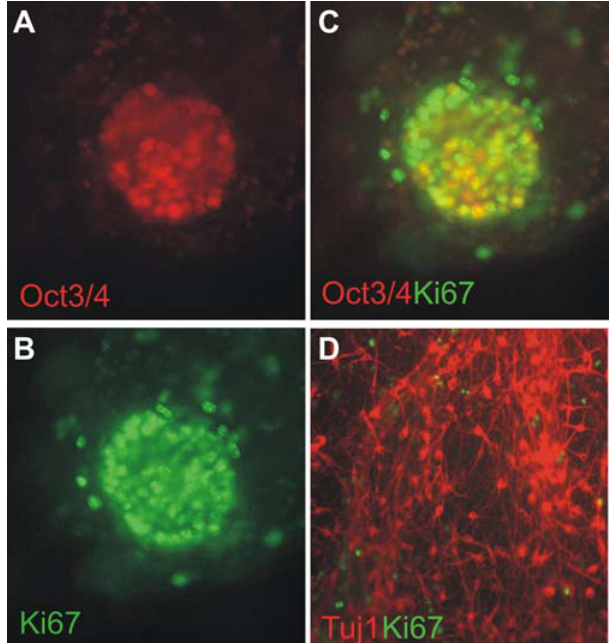
Figure 3. Some of the ES cell-derived neuronal colonies still contain at day 14 OCT3/4 and Ki67-positive cells. (A) After 14 days of differentiation culture few colonies (less than 5%), as exemplified here, still contain OCT3/4-positive cell clusters as detected by immunofluorescence staining using a specific mAb (magnification 40 6 ). (B) The same colony was stained by an anti-Ki67 mAb to detect proliferating cells. (C) The merged staining indicates that Ki67-positive proliferating cells exist which are not OCT3/4-positive stem cells. (D) In parallel, cells of the neuronal differentiation culture were stained at day 14 by anti-Ki67 and anti-Tuj1 mAb. The merged staining (magnification 20 6 ) indicates that the vast majority of the cells are Tuj1-positive neuronal cells. Few Ki67-positive proliferating cells are negative for the neuronal cell marker.